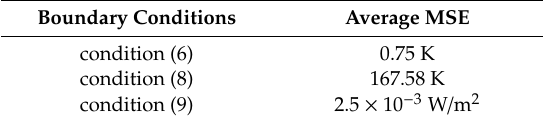
Table 3. Average mean square errors (MSEs) for boundary conditions (6), (8), and (9).